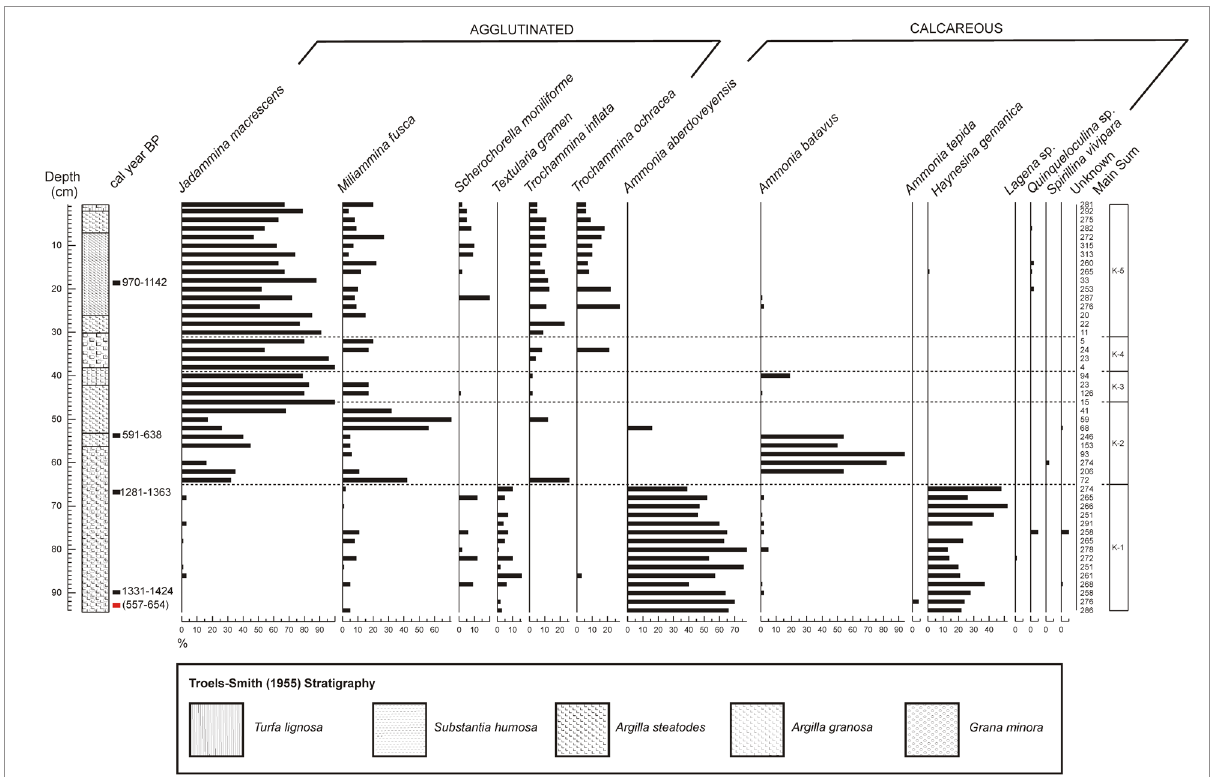
Figure 3: Foraminiferal concentrations down core KAR2. Indicated in the figure is the Troels-Smith 43 stratigraphy and the zonation derived from a constrained incremental sum of